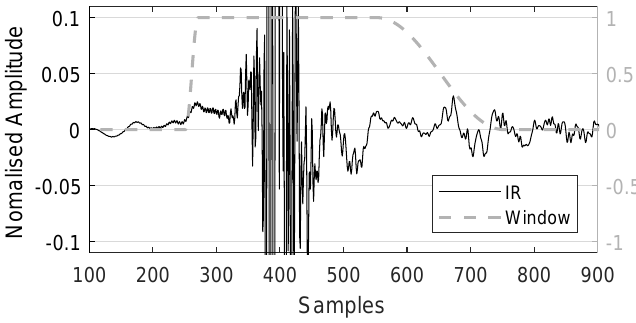
Figure 5. Windowing of HRTFs to 500 samples by means of a 20 sample half Hanning window and 130 sample pad before each peak and a 150 sample pad and 200 sample half Hanning window after. Note that the plot has zoomed in on the IR to illustrate the region of